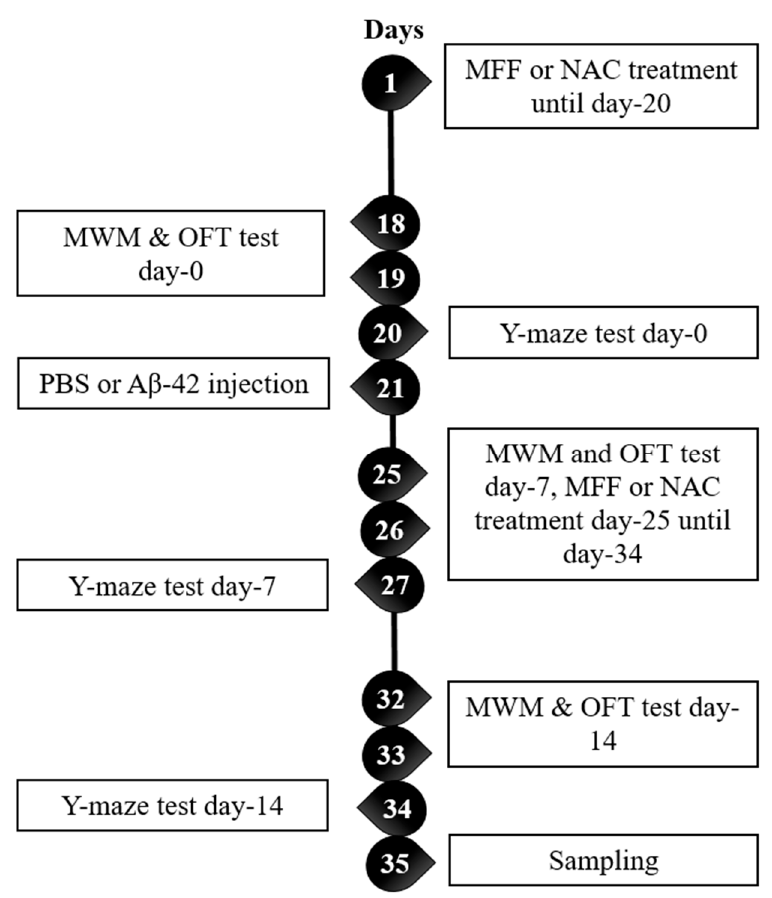
Figure1. Experimenttimelinefromday1today35. MFF:mixedfunctionalfoods, NAC:n-acetylcysteine, Figure 1. Experiment timeline from day 1 to day 35. MFF: mixed functional foods, NAC: n- MWM: Morris water maze, OFT: open field test, PBS: phosphate bu ff er acetylcysteine, MWM: Morris water maze, OFT: open field test, PBS: phosphate buffer solution.